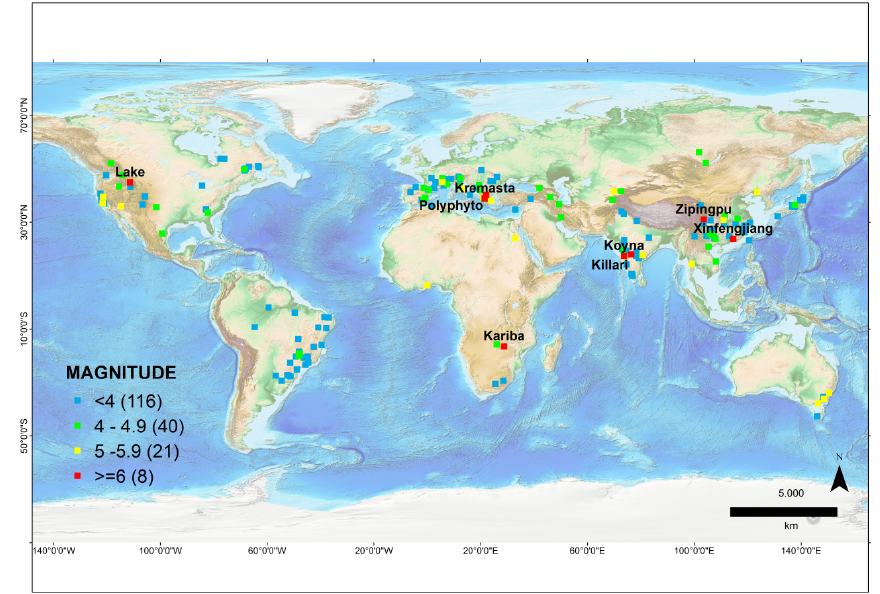
Figure 1. World map of events triggered by reservoirs. (Data from the http://inducedearthquakes.org/; last access: 10 May